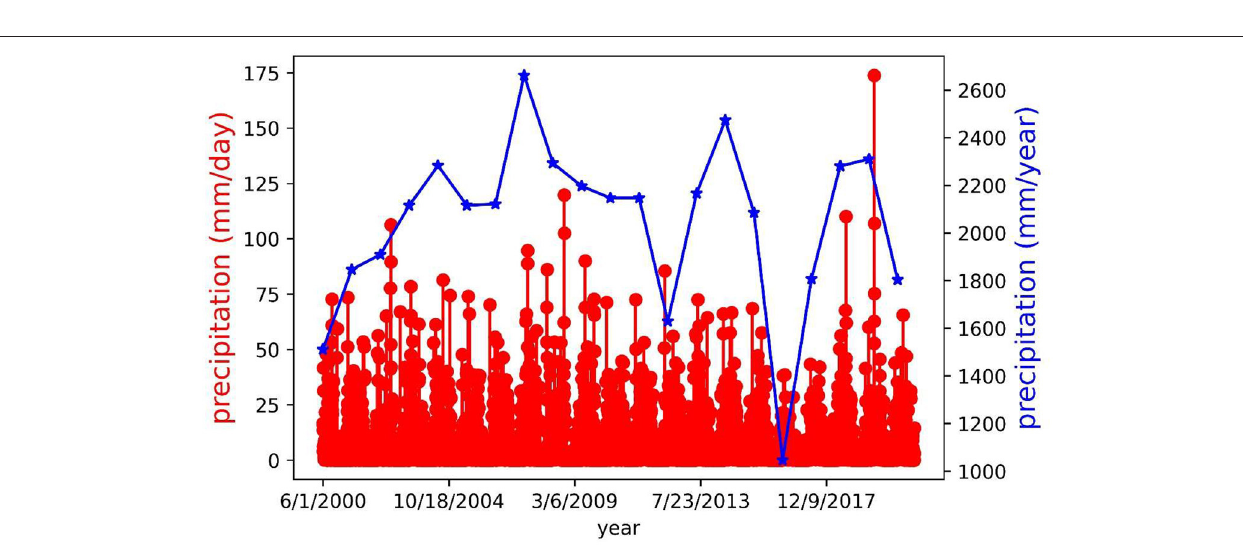
FIGURE 3 | Variation in temperature anomaly over a lake for a period of two decades from 2000 to 2020. The trend line indicates an increase in temperature of 0.018 ◦ C per year.